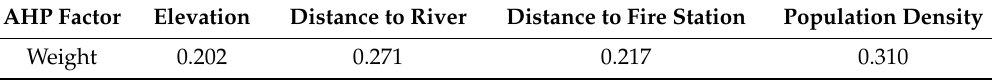
Table 2. Vulnerability weight values from the